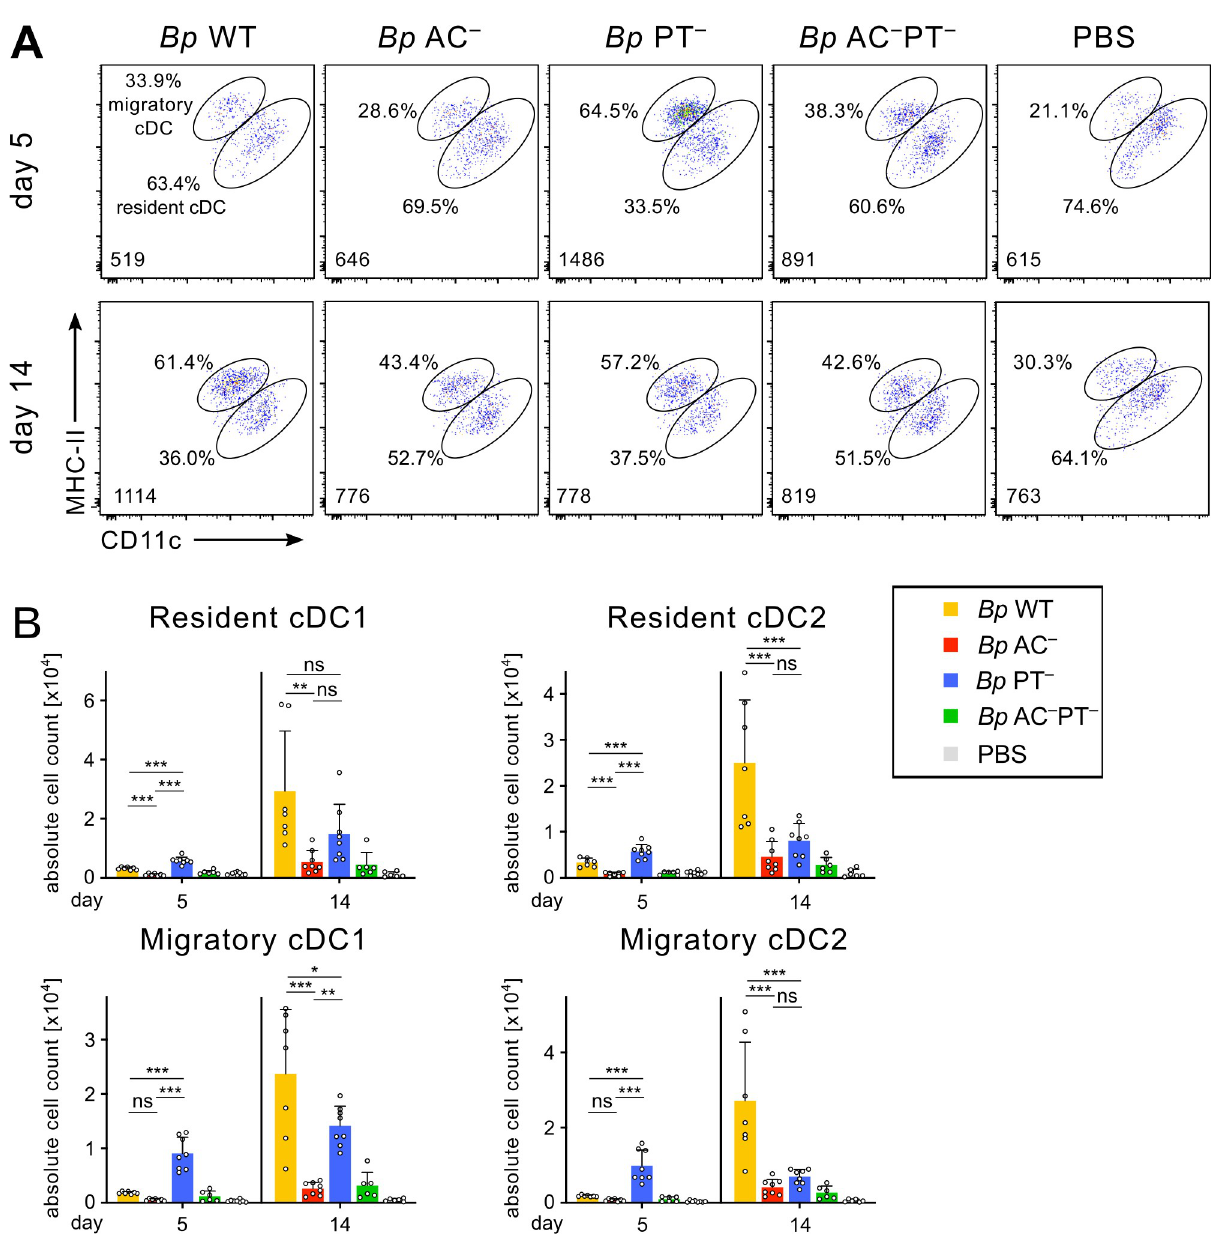
Fig 7. PT activity blocks early arrival of migratory cDCs from infected lungs to mLNs. Mice were intranasally infected with 8 × 10 5 CFU of the indicated B . pertussis strains expressing mScarlet fluorescent protein. Collected mLNs were pooled, enzymatically disrupted and the cell suspensions were analyzed by flow cytometry using a panel of monoclonal antibodies and cell counting beads. (A) Representative dot plots of the migratory cDCs (MHC-II high CD11c int ) and resident cDCs (MHC-II int CD11c high ) detected in mLNs of infected mice on day 5 (upper panel) and 14 (lower panel). The indicated conventional dendritic cell (cDC) numbers (lower left corners) were gated-out from 100,000 viable singlets per sample as described in S12 Fig. The percentage (%) of cDC subpopulations are indicated. (B) Total counts of migratory and resident cDC1 (CD11b – ) and cDC2 (CD11b + ) cells in mLNs of infected mice on days 5 and 14. Each symbol represents the value for an individual animal. Data represent mean values and standard deviations for groups of four mice per time point (or 2 mice in Bp AC – PT − group) from two independent experiments. Statistical significance between groups was analyzed by one-way ANOVA followed by Tukey’s multiple comparisons test. � (p < 0.05), �� (p < 0.01), ��� p ( <